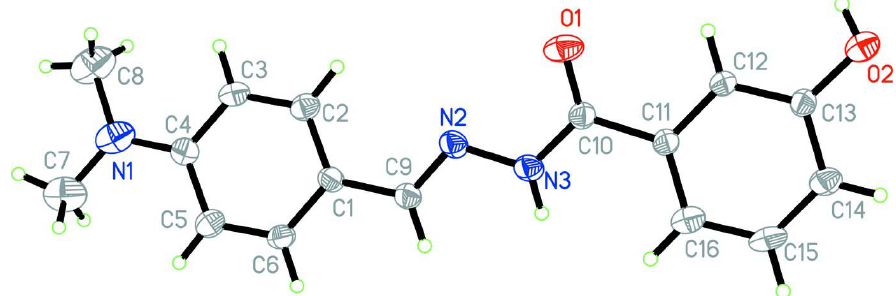
the 30% probability